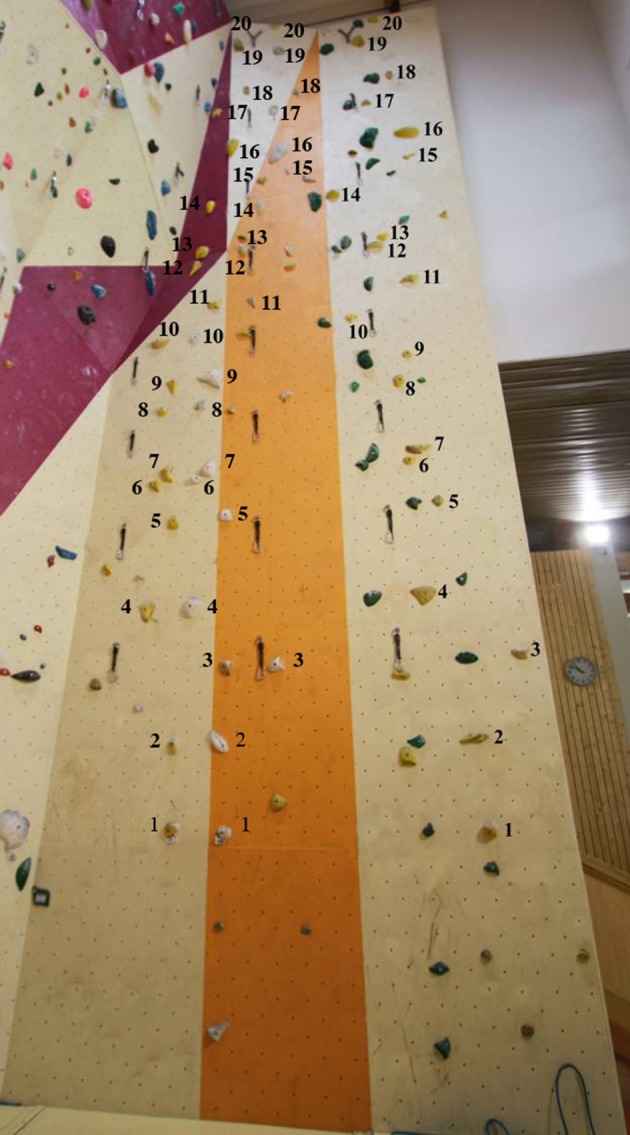
Location of the 20 hand-holds for the three routes. Adapted from Seifert et al. (2015).